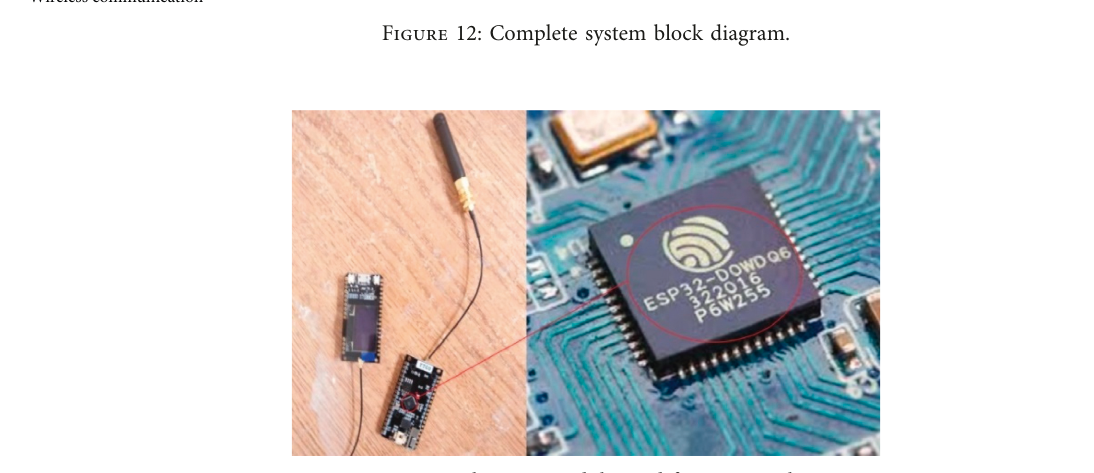
Figure 12: Complete system block diagram.